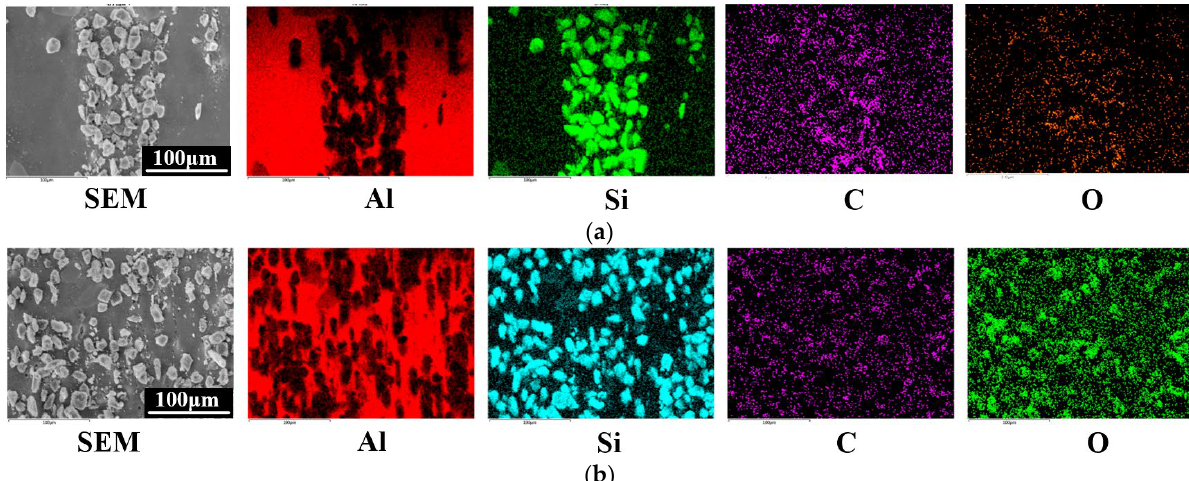
Figure 12. The energy spectrum of EDS element distribution on the machined surface at a voltage of 40V: ( a ) JECM; ( b ) PAJECM.